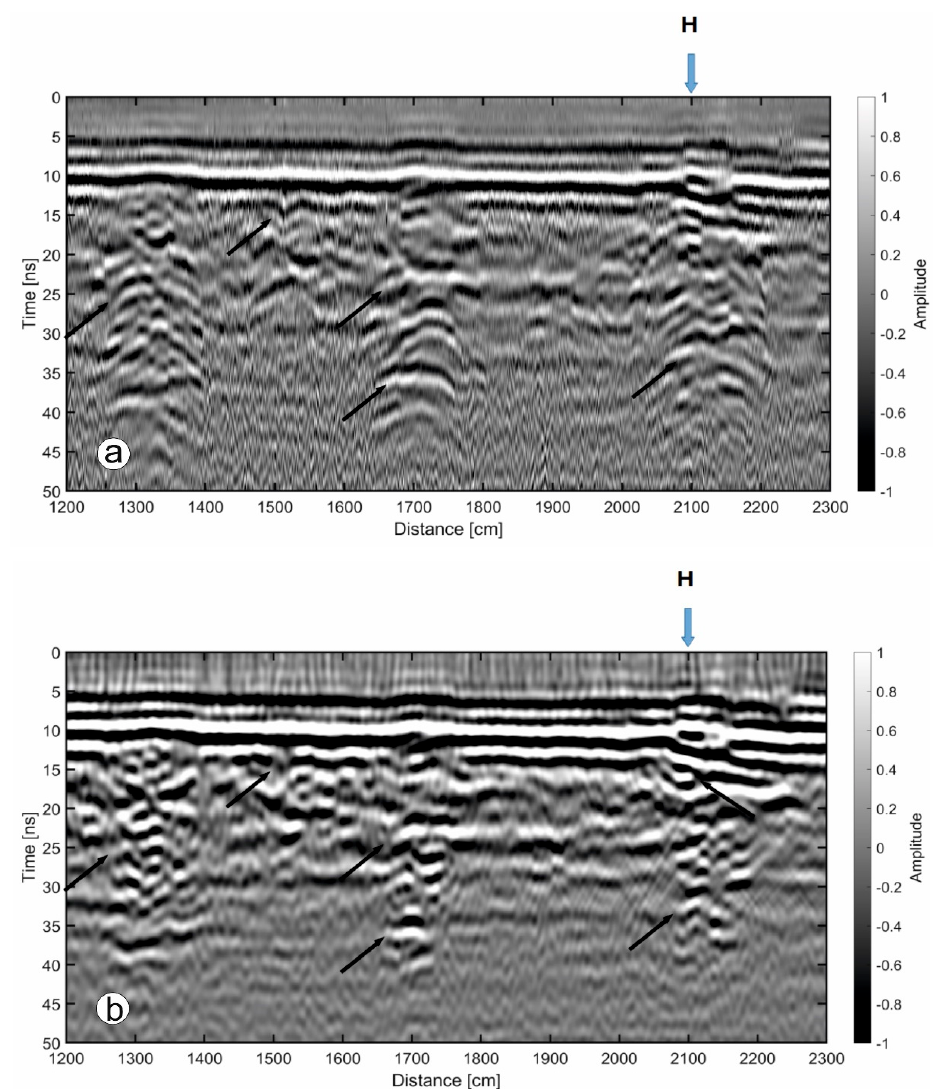
Figure 9. ( a ) A close-up of the L92 section; ( b ) a close-up of the L92 migrated section. Migration has the effect of delineating with higher accuracy the geometry of the buried objects. The black arrows indicate some points in the section where the migration outcomes are particularly evident.